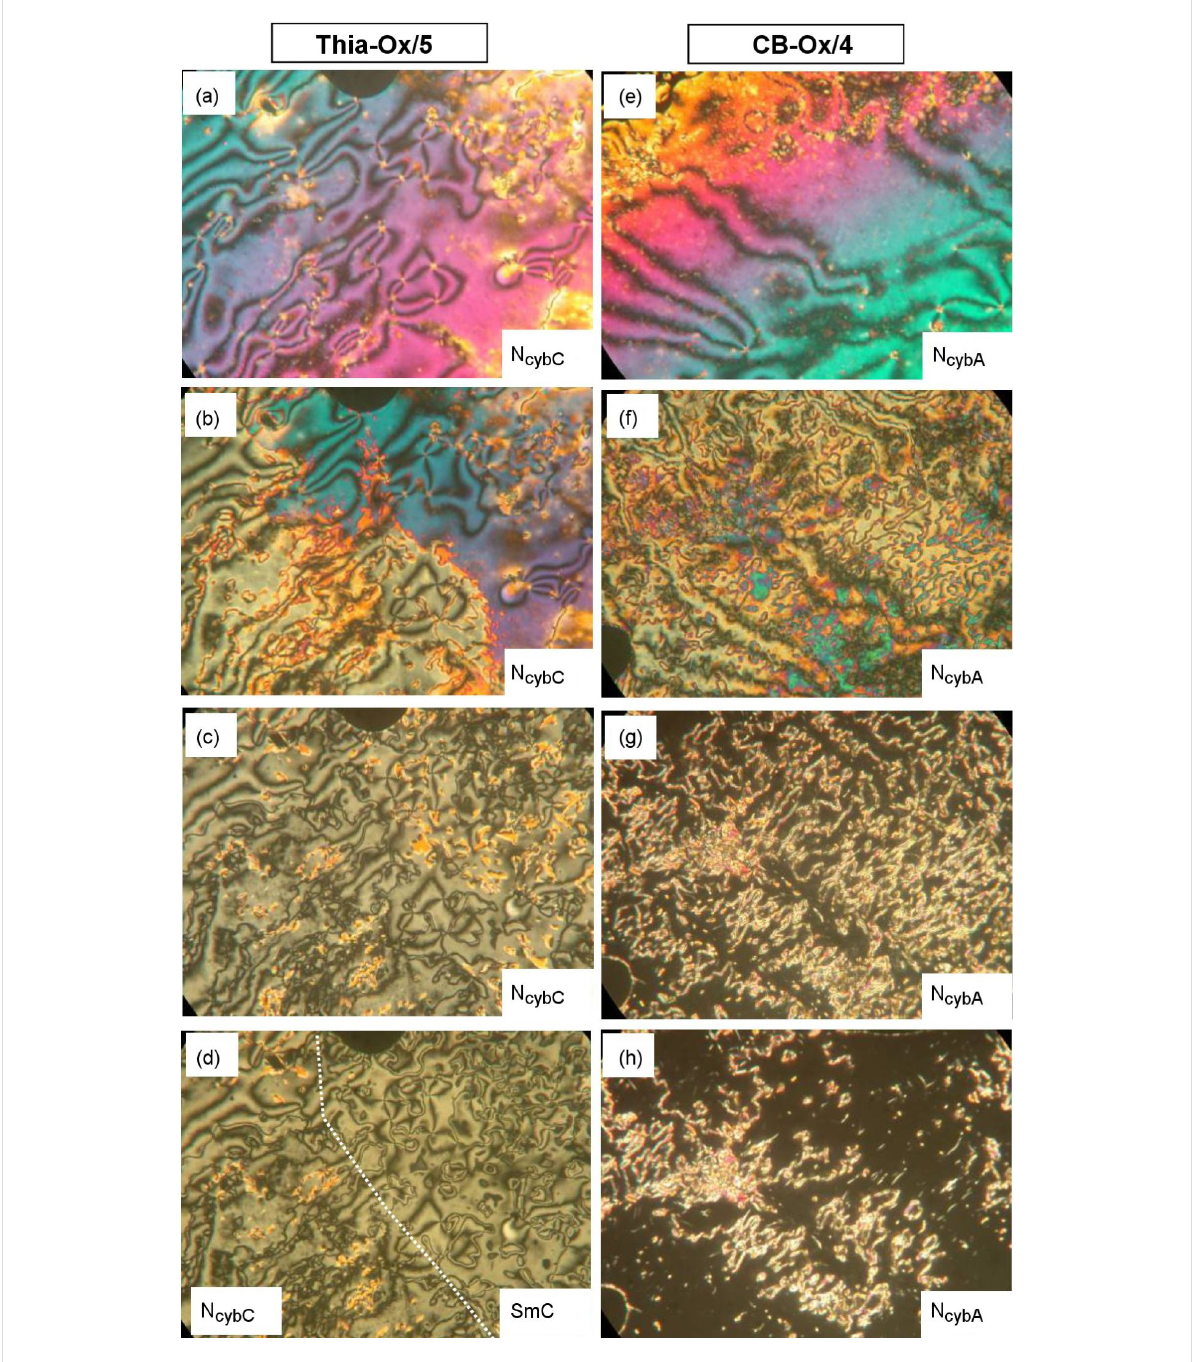
Figure 8: Comparison of the optical textures of distinct types of 1,2,4-oxadiazole based dimesogens as observed between nontreated glass plates (Menzel cover glasses, Menzel GmbH, Braunschweig) between crossed polarizers: (a–d) compound Thia-Ox/5 at (a) T = 206 °C; (b) T = 197 °C; (c) T = 178 °C; (d) T = 173 °C N cybC -to-SmC transition, the dotted line indicates the phase boundary; (e–h) compound CN-Ox/4 at (e) T = 254 °C; (f) T = 232 °C; (g) T = 178 °C; (h) T = 150 °C (at T = 146 °C in the CybA phase all birefringence has